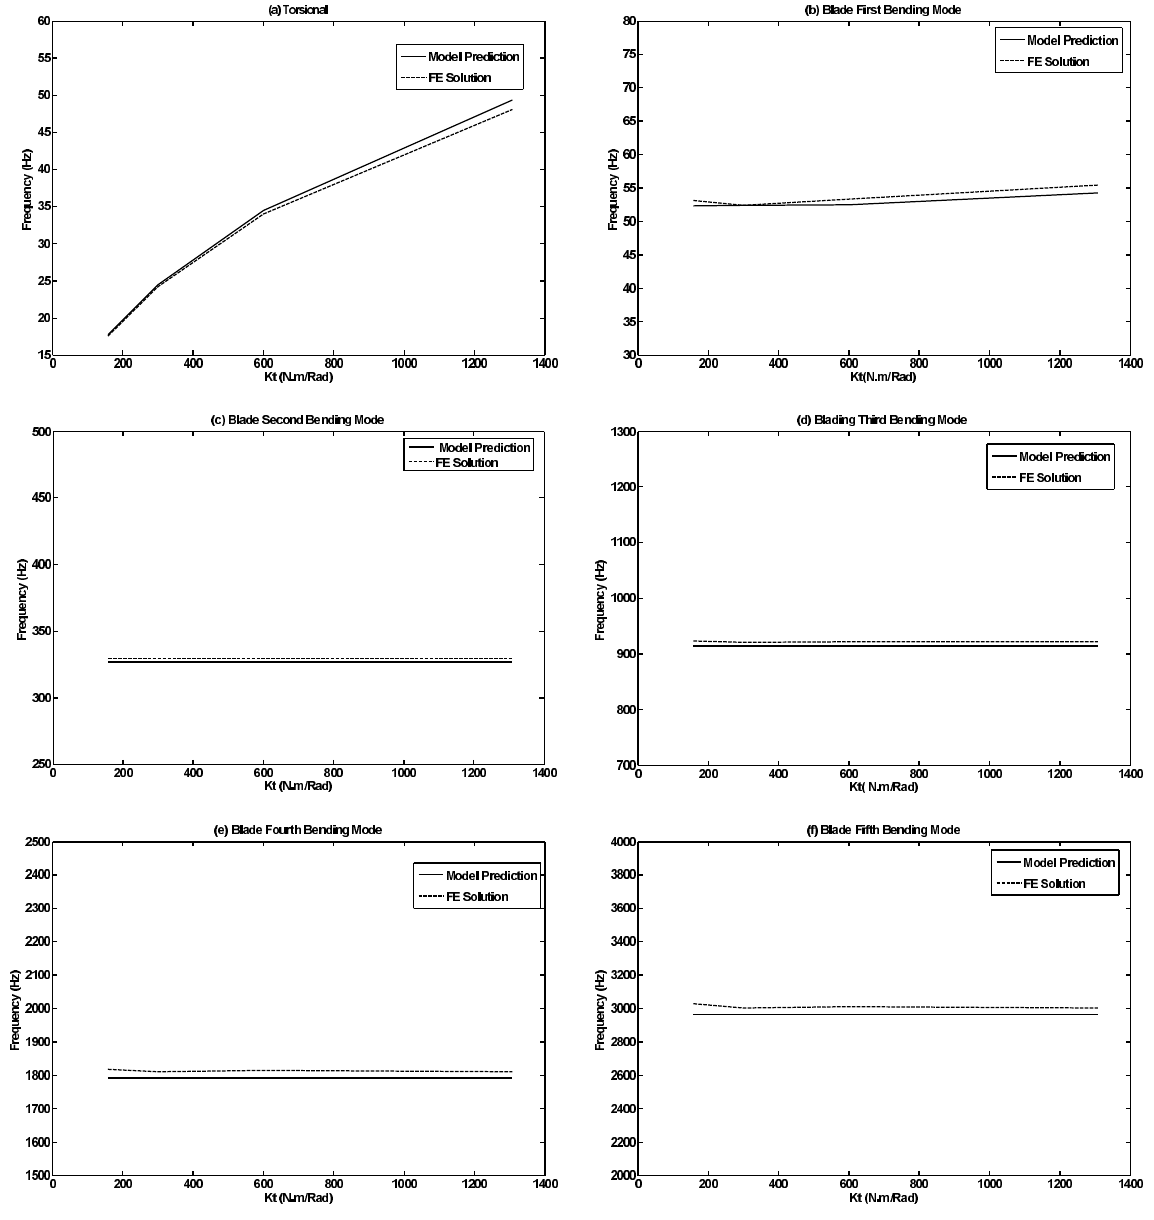
Fig. 10. FEM Model Shaft torsional and blade bending modes for k T = 300 N.m/Rad, β = 30 ◦